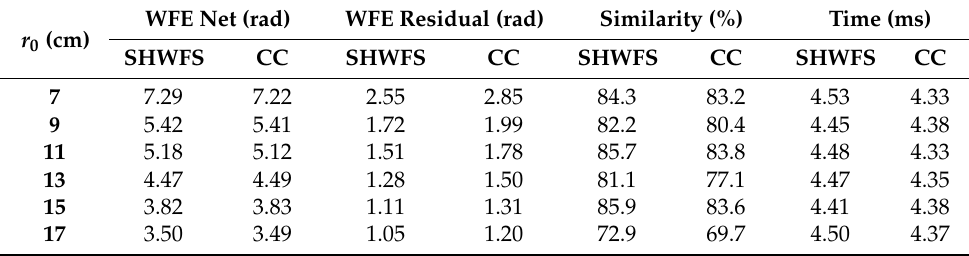
Table 1. Results obtained for the ground layer reconstructions. WFE net refers to the RMSE WFE calculated over the images given by each FCN as output, while WFE residual refers to the RMSE WFE of the image that is obtained as the difference between the output of one ANN and the original simulated image. Both terms are measured in radians (rad). SHWFS refers to the ANN that uses as input the information received by the subapertures of the sensor, while CC refers to the ANN that uses the cross-correlations (CC) as inputs. The time column shows the mean time over the dataset per sample for each ANN, measured in milliseconds (ms).